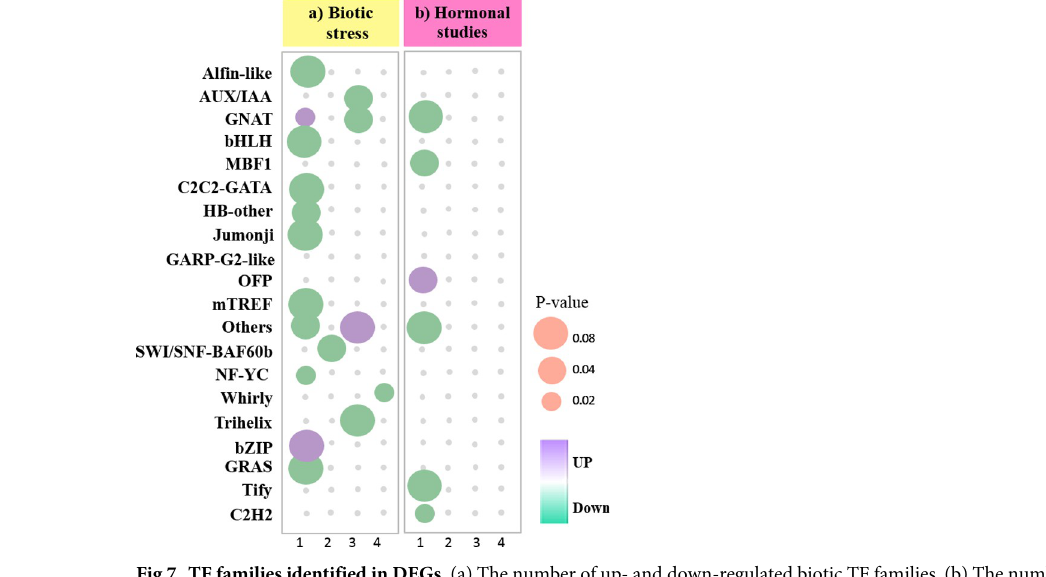
The psRNATarget tool was used for predicting potential miRNAs that target the DEGs. Among the biotic DEGs, 432 miRNAs belonging to 56 conserved families were found (S6 Table). Furthermore, 85 miRNAs belonging to 32 conserved families were identified among hormonal DEGs (S6 Table). It was found that 15 target genes were common across both data- sets; of which miR6192 was the most frequent (Fig 8A). All the putative target genes such as Ribosomal Protein S1 ( RPS17 ), ROF2 ( FKBP65 ), Eukaryotic Translation Initiation Factor 3 Subunit E ( EIF3E ), RNA polymerase I-associated fac- tor ( PAF67 ), Abnormal Inflorescence Meristem ( AIM1 ), and PKT3 were GO categorized. The results showed that these genes were involved in different MFs, i.e., oxidoreductase, transfer- ase, and enzyme regulatory activities, and played roles in many BPs, i.e., metabolic, cellular, and biosynthetic processes (Fig 8B).